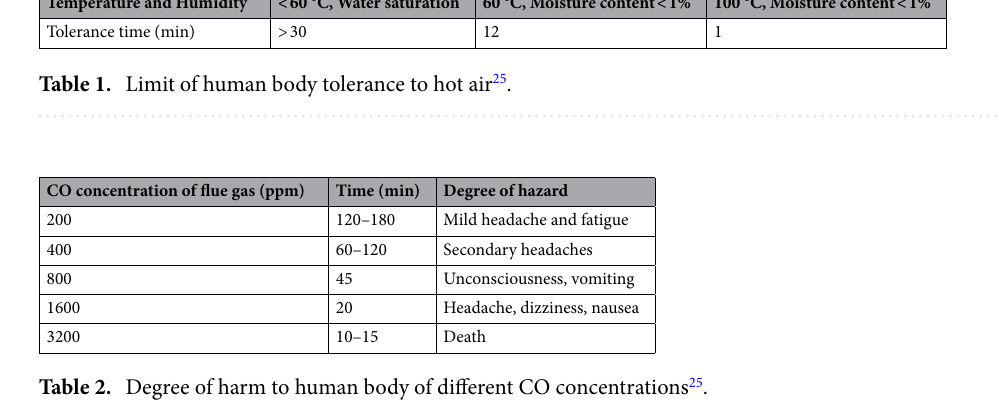
Table 2. Degree of harm to human body of different CO concentrations 25